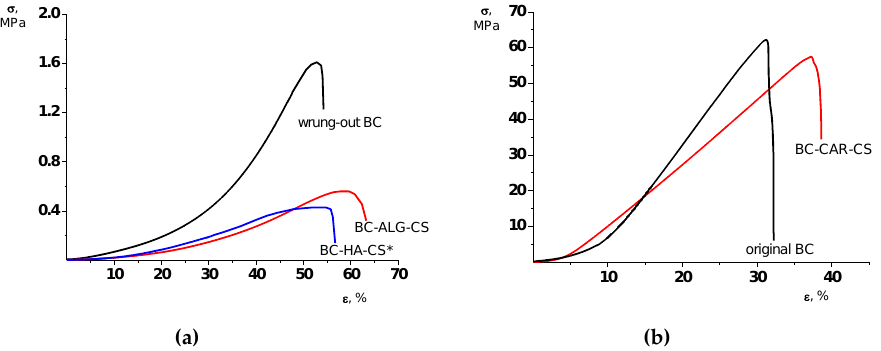
Figure 1. Stress–strain curves of gel-films studied: ( a ) wrung-out BC, BC–ALG–CS, and BC–HA–CS*; and ( b ) original BC and BC–CAR–CS.